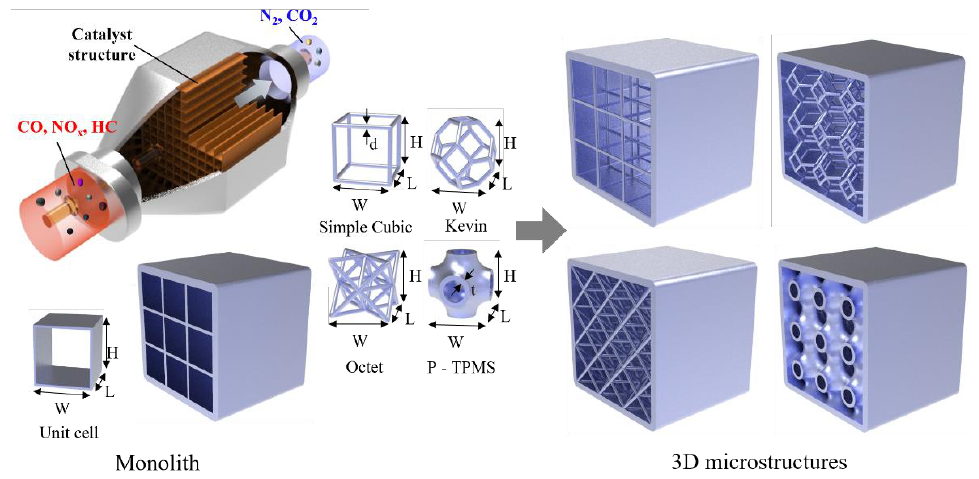
Figure 1. Schematic of the three-dimensional (3D) microstructures applied to improve the catalytic conversion efficiency of the conventional monolithic catalytic converter.